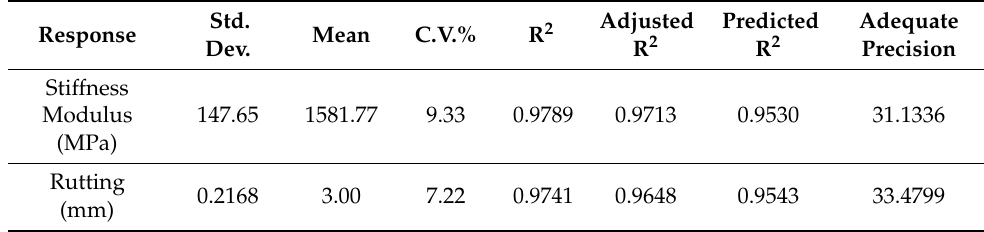
Table 6. ANOVA results for